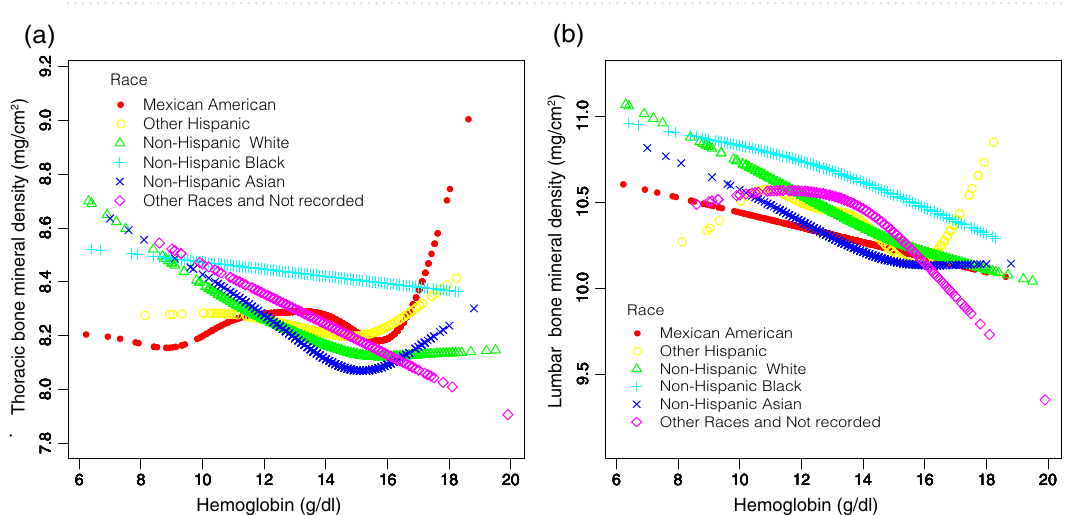
Figure 5. The hemoglobin and bone mineral density relationship, stratified by race. Age, sex, annual household income, education level, SBP, DBP, BMI, red blood cell count, albumin, ALP, ALT, blood urea nitrogen, total calcium, iron, CPK, creatinine, glucose, LDH, phosphorus, total bilirubin, total protein, uric acid, albumin creatinine ratio, blood cadmium, blood lead, phosphorus, potassium, triglyceride, LDL-C, HDL-C, total cholesterol, alcohol status, smoking status and diabetes were adjusted. ( a ) Thoracic BMD; ( b ) Lumbar BMD. Red line: Mexican American; Yellow line: Other Hispanic; Green line: Non-Hispanic White; Light blue line: Non-Hispanic Black; Dark blue line: Non-Hispanic Asian; Purple line: Other Races and Not